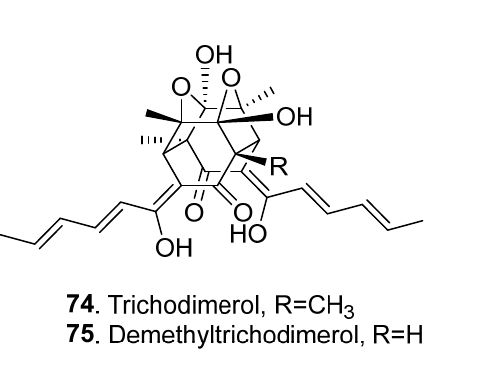
Table S3). Two hybrids, 10-methylsorbiterrin ( 61 ) and dihydrotrichodermolidic acid ( 62